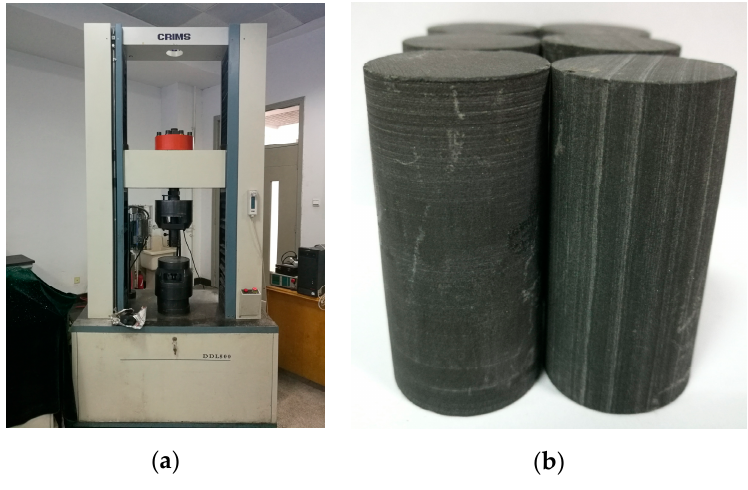
Figure 4. Laboratory testing on shale specimen: ( a ) testing machine and ( b ) shale specimens.